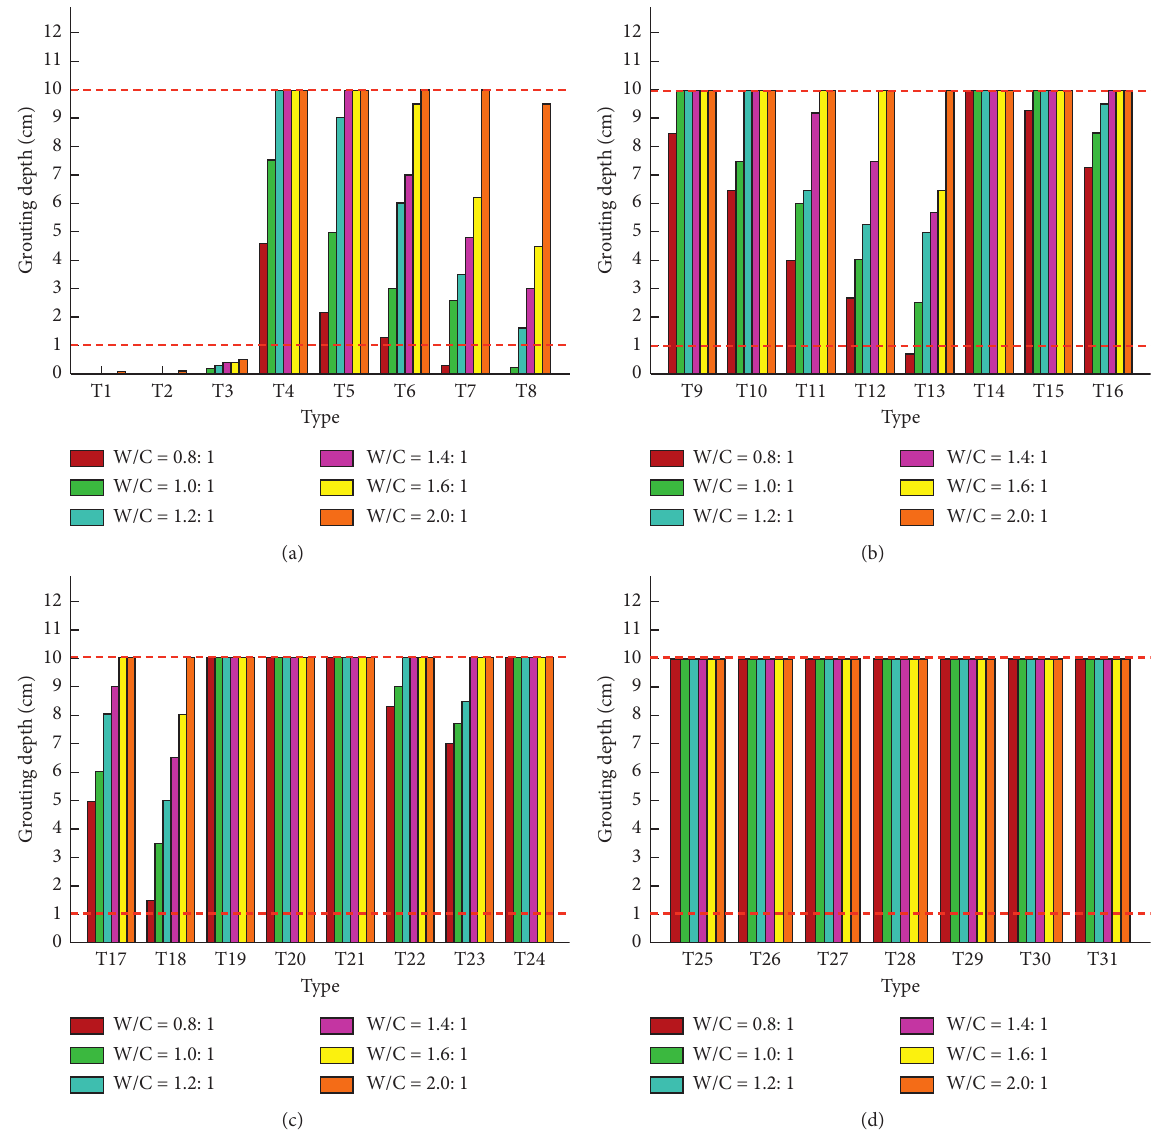
Figure 5: Results of the groutability